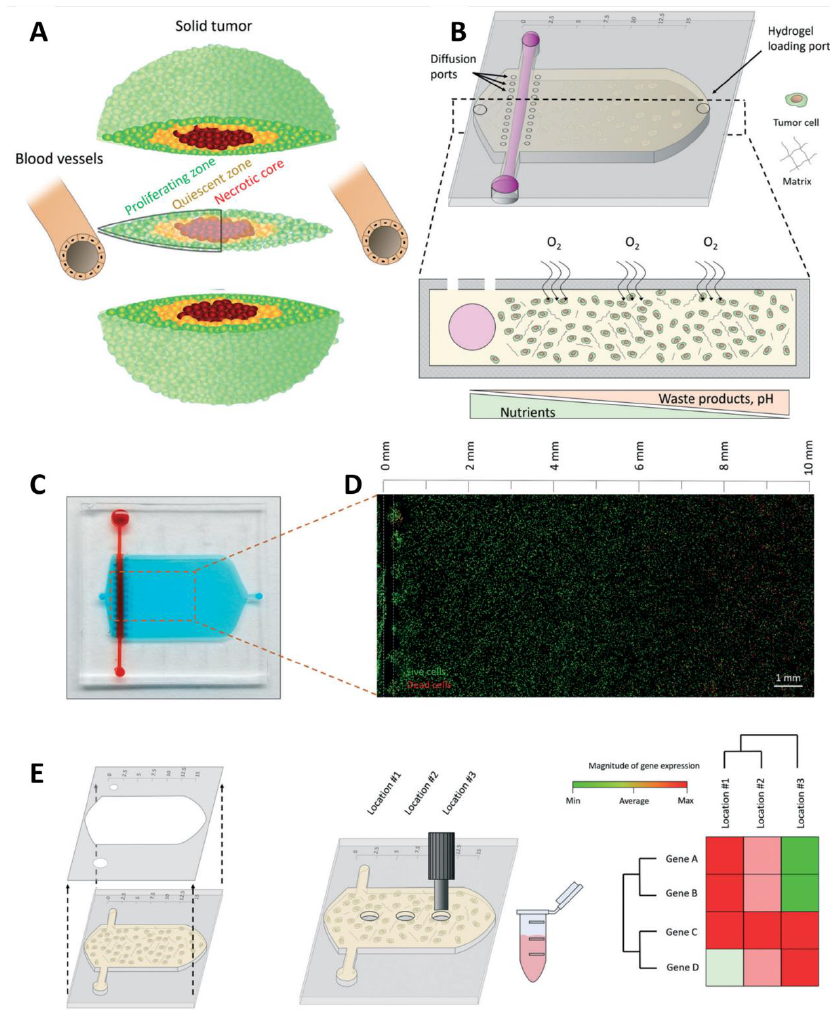
Figure 6. ( A ) Schematic representation of the different tumor phenotypes generated in a solid tumor due to nutrient starvation; ( B ) scheme of the tumor slice microdevice showing the central microchamber, the lumen, and the different loading and diffusion ports. The bottom panel shows the microdevice cross-section. HCT-116 cells were embedded in a collagen hydrogel, the lumen, as well as the pores in the upper half to allow nutrient diffusion. ( C ) Picture of the microdevice filled with blue and red-colored water for visualization purposes. ( D ) Confocal image showing HCT-116 cell viability after 24 h in the microdevice at 10 million cells/mL. Viable and dead cells are shown in green and red, respectively. White dashed line indicates the lumen position. ( E ) Scheme illustrating the protocol to retrieve the cells from the device. Both halves are disassembled, exposing the collagen hydrogel, and then hydrogel punches are isolated using a biopsy puncher. Reprinted with permission from Ref. [143]. Copyright 2019 Royal Society of Chemistry.